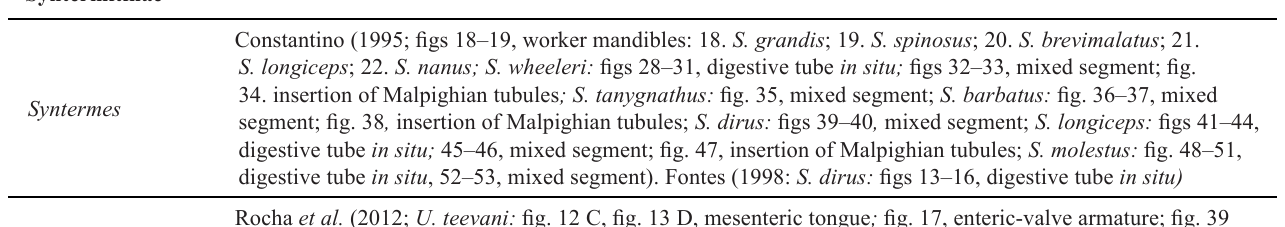
Table 1. List of taxonomic studies that treat the worker caste of Neotropical Termitidae genera. (Continuation)